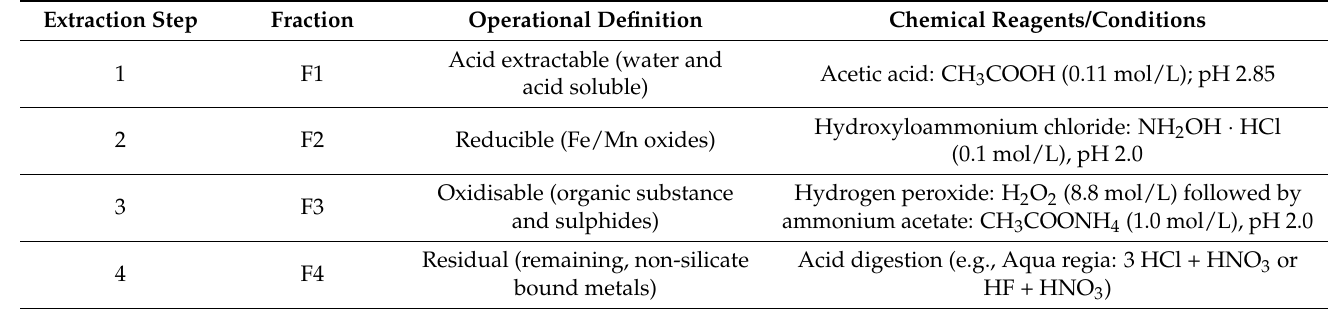
Table 4. The BCR three-steps sequential extraction scheme